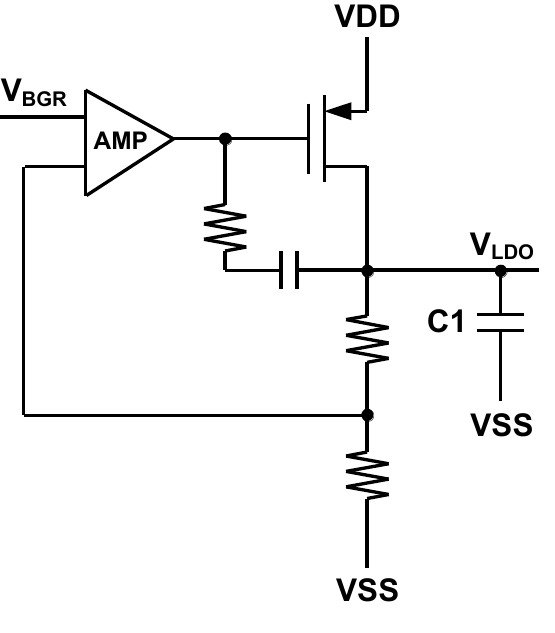
Figure 11. LDO schematic.